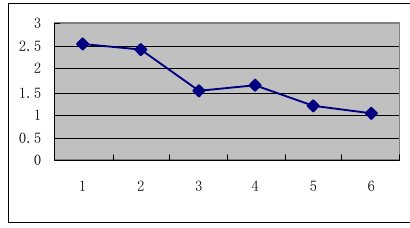
Fig.8. One-dimension projection for MII